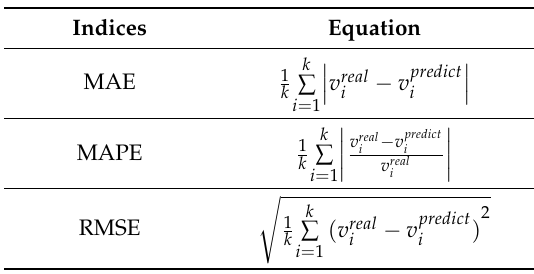
Table 2. The indices for prediction error (MAE, RMSE,